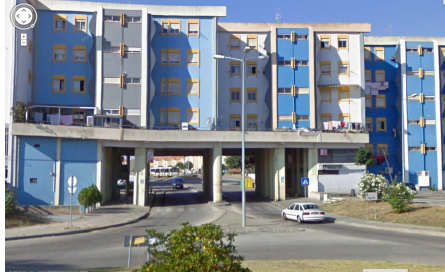
Figure 7 - Complex 3D cadastre occurrences in Coimbra (Portugal): block of apartments (property units) over an urban road (public space) – source: